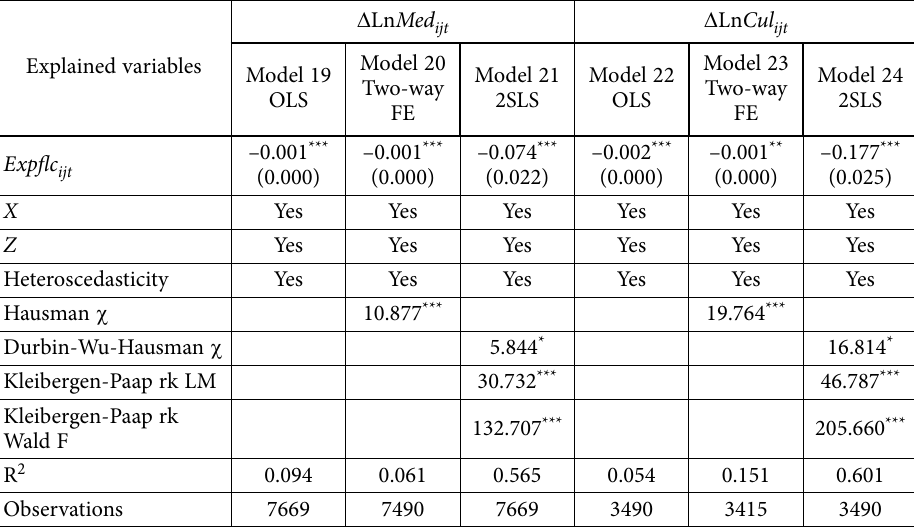
Table 10. Estimated results of other forms of consumption spending